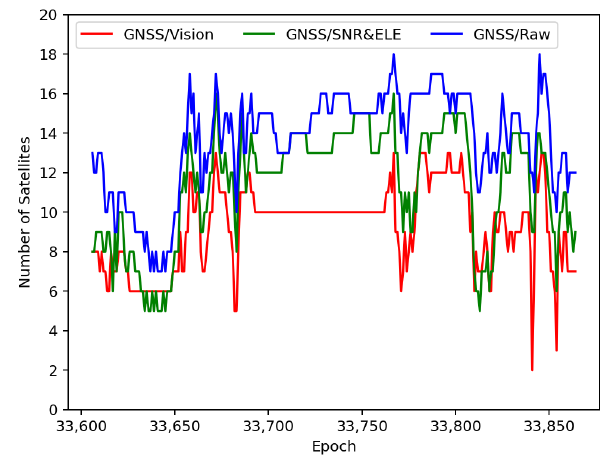
Figure 21. Comparison of the number of